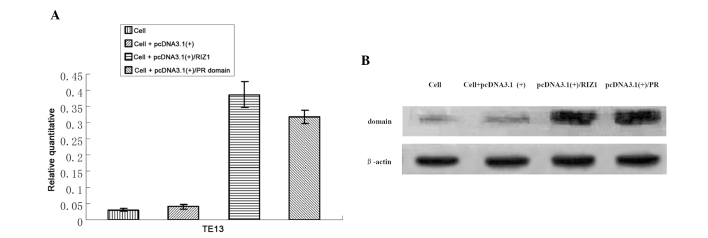
(A) Quantitative reverse transcription polymerase chain reaction analysis of RIZ1 and PR domain mRNA expression levels in TE13 esophageal squamous cell carcinoma cells transfected with either pcDNA3.1(+)/RIZ1 or pcDNA3.1(+)/PRDI-BF1-RIZ (PR) domain. The RIZ1 and PR domain mRNA expression levels were normalized to those of β-actin. The difference in expression levels between the untransfected and empty vector-transfected cells (negative controls) was not statistically significant (P>0.05). Significantly higher RIZ1 and PR domain mRNA expression levels were detected in cells transfected with pcDNA3.1(+)/RIZ1 or pcDNA3.1(+)/PR domain (P<0.01). (B) Western blot analysis of RIZ1 and PR domain protein expression levels in TE13 cells transfected with either pcDNA3.1(+)/RIZ1 or pcDNA3.1(+)/PR domain. β-actin served as a loading control and untransfected and empty vector-transfected TE13 cells served as the negative control. Significantly higher RIZ1 and PR domain protein expression levels (P<0.01) were detected in cells transfected with pcDNA3.1(+)/RIZ1 or pcDNA3.1(+)/PR domain compared with negative controls.